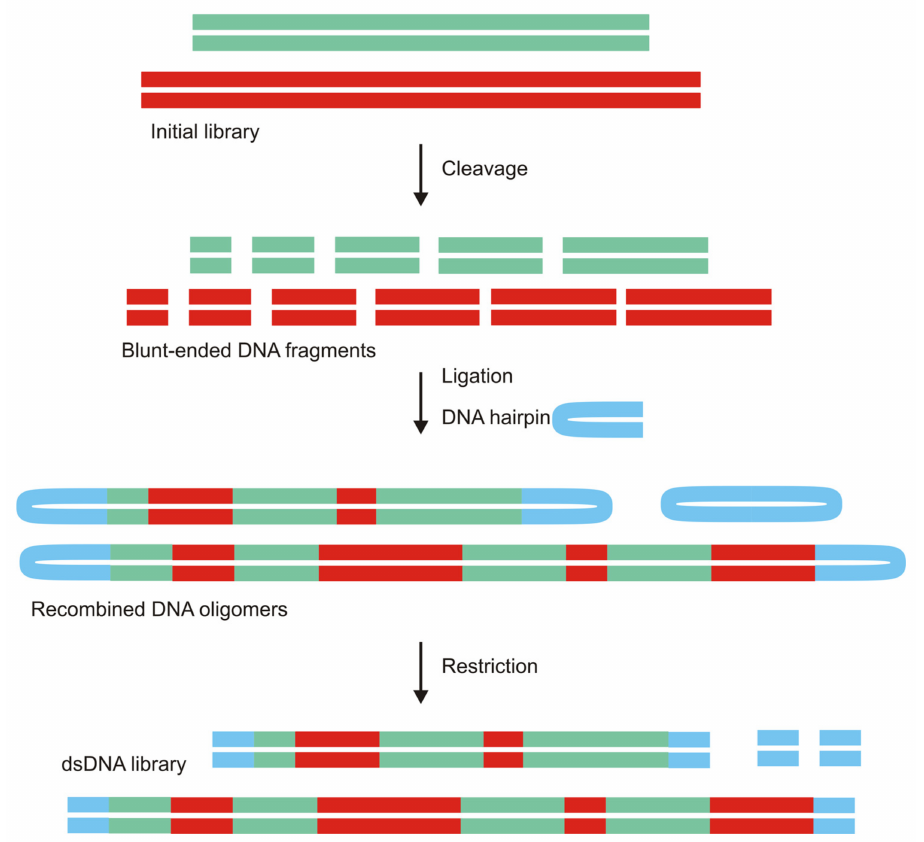
Figure 6. A scheme of the nonhomologous random recombination method